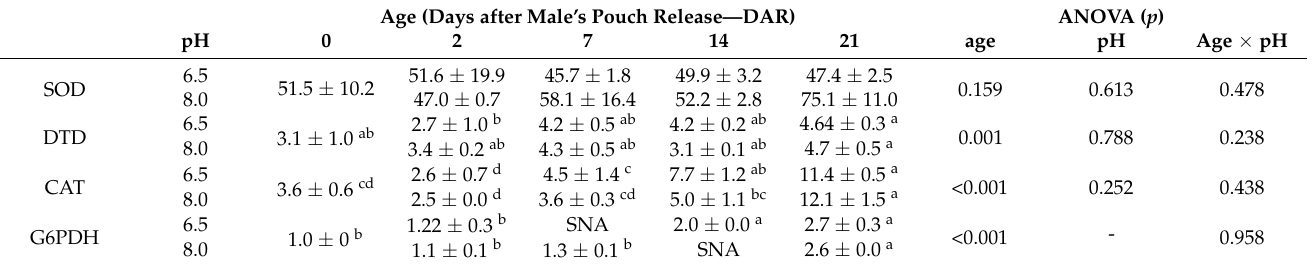
Table 4. Trial 1 (SW)—Enzymatic activities (mean ± standard deviation) in H. reidi juveniles reared in seawater (SW—salinity 33) at pH 6.5 or 8.0 for 21 days (age 0–21 DAR—days after the male’s pouch release).